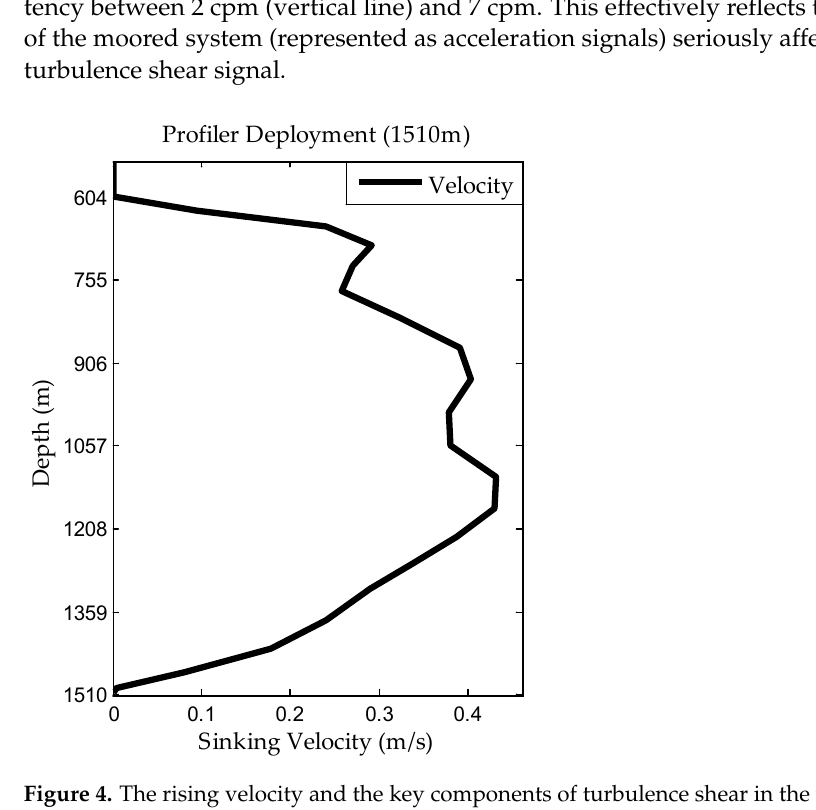
Figure 4. The rising velocity and the key components of turbulence shear in the whole process.